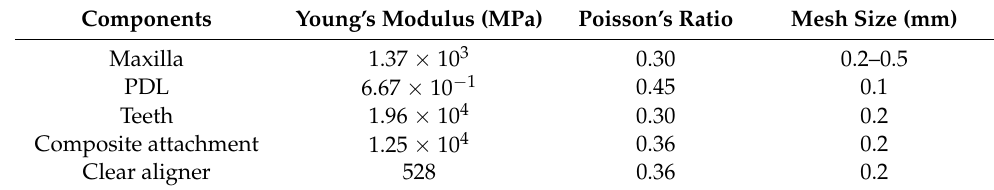
Table 1. Material properties and mesh size.